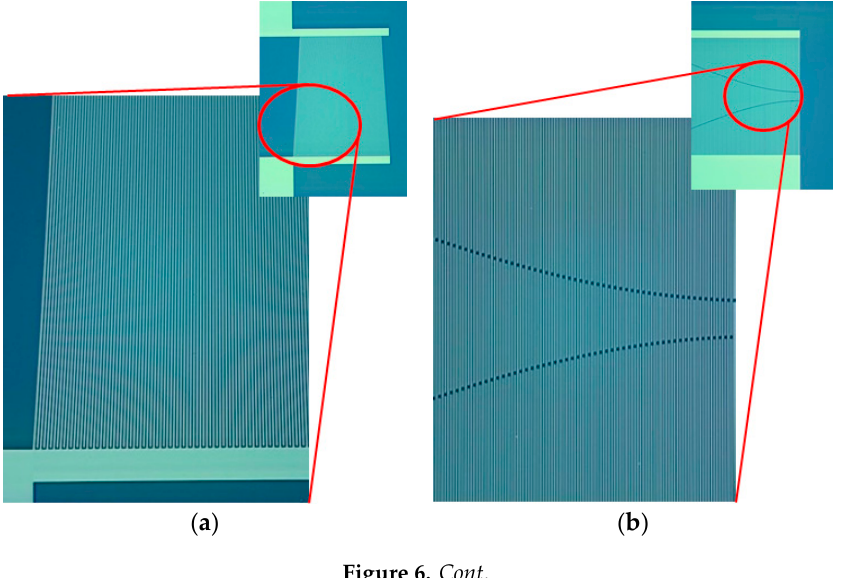
Figure 5. Fabrication procedure. ( a ) LN waveguide bonding onto Si wafer, ( b ) Al patterns for wide bandwidth IDTs, ( c ) PR patterns for masking and protection layer during DRIE process, ( d ) DRIE, ( e ) cleaning with microstriper, ( f ) light blocker assembling for effective light coupling, ( g ) Al patterns for lens, ( h ) SU ‐ 8 spin coating and then UV exposure via proximity lithography, ( i ) developing process to form hemisphere shape of the polymer, ( j ) Al patterns, ( k ) PZT patterns via RF sputter, and ( l ) Al patterns for sandwiched PZT by two electrodes and lift ‐